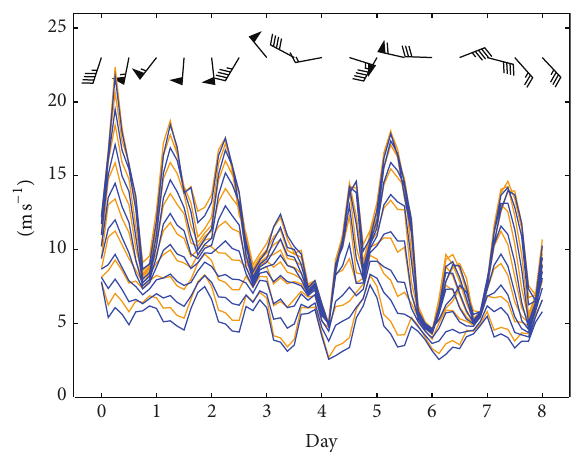
Figure 5: Average horizontal wind speed at the lowest 8 grid wind levels of 15 , 52 , 102 , 165 , 245 , 345 , 466 , and 648 meters above ground. Orange is without wind turbines. Blue is with 2 MW wind turbines deployed at CD = 2.5 Wm −2 capacity. Top of the rotor is at 98 m (careful counting shows that blue curve is below the corresponding orange curve). The wind barbs represent the horizontal wind direction and magnitude at 102 m at the center of the wind farm area, but without wind turbines. Half barbs are 1 ms −1 , full barbs 2 m s −1 , and flags 10 ms −1 . Days are ticked at 0 UTC,lateafternoonatthewindfarm,atwhichtimethewindspeed has become more well mixed across the boundary